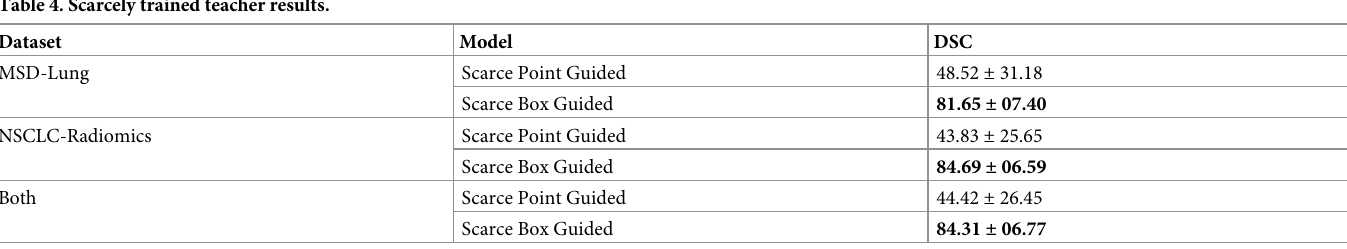
Table 4. Scarcely trained teacher results.